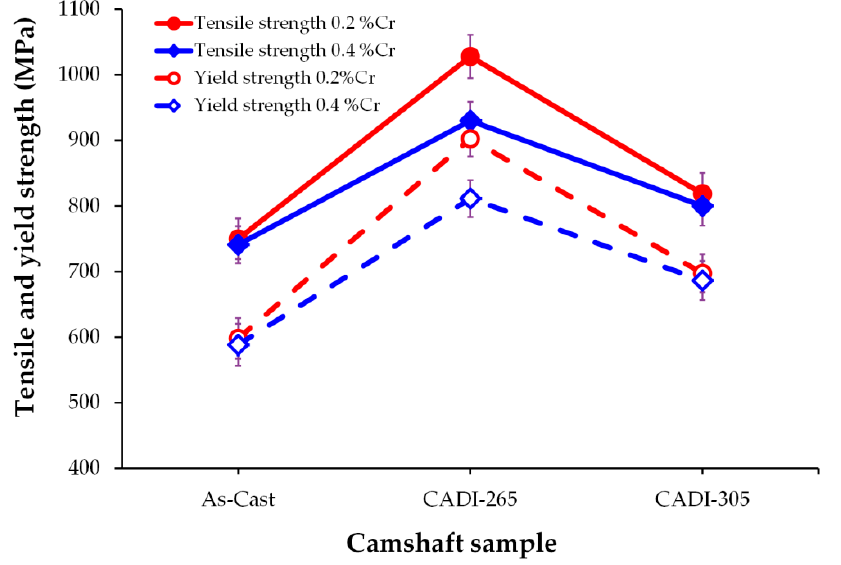
Figure 13. Influence of chromium content and austempering temperature on yield and tensile strength of the CADIs produced.